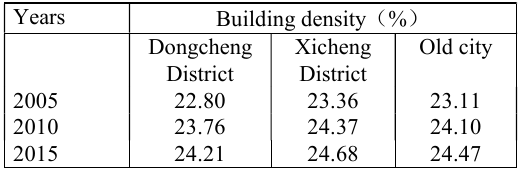
Table 1. Building density of each district